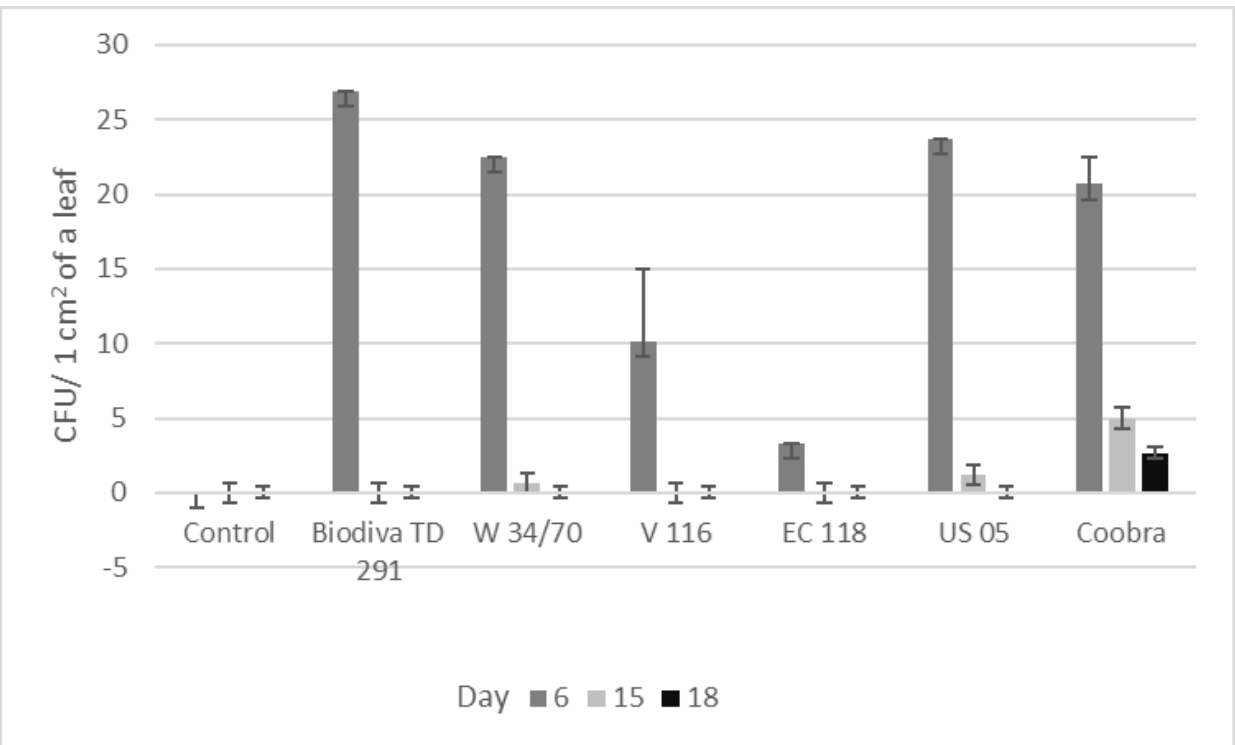
Figure 4. Survival of the population of antagonistic yeast strains on the surface of the potato leaves in greenhouse conditions [CFU/1 cm 2 ] ±